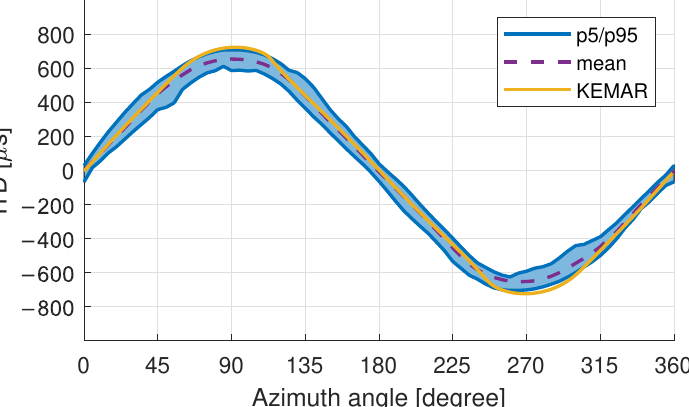
Figure 6. ITD data in the horizontal plane of children HRTF measurements compared to a KEMAR artificial